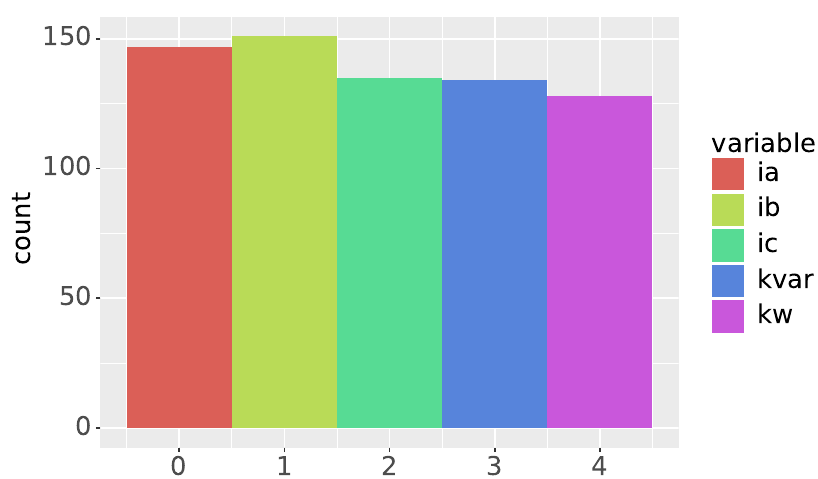
Figure 14. Variables distribution for SMAPE < 10%.